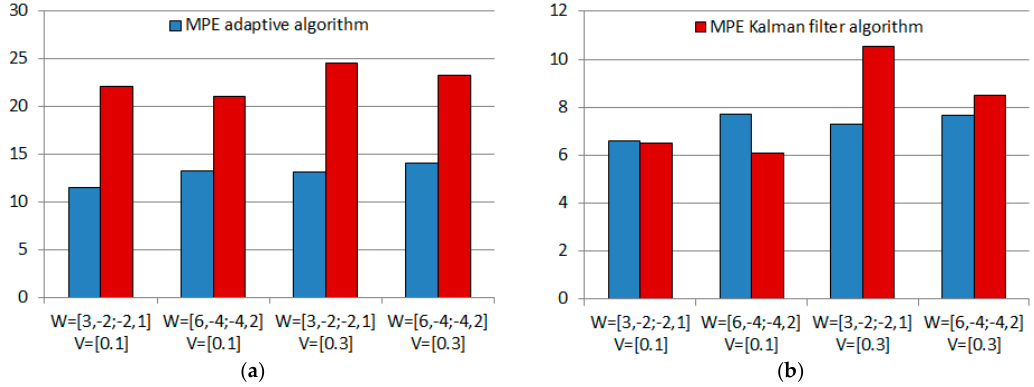
Figure 14. Mean percentage error (MPE) quality indicators for BOD ( a ) and DO ( b ) signals generated.